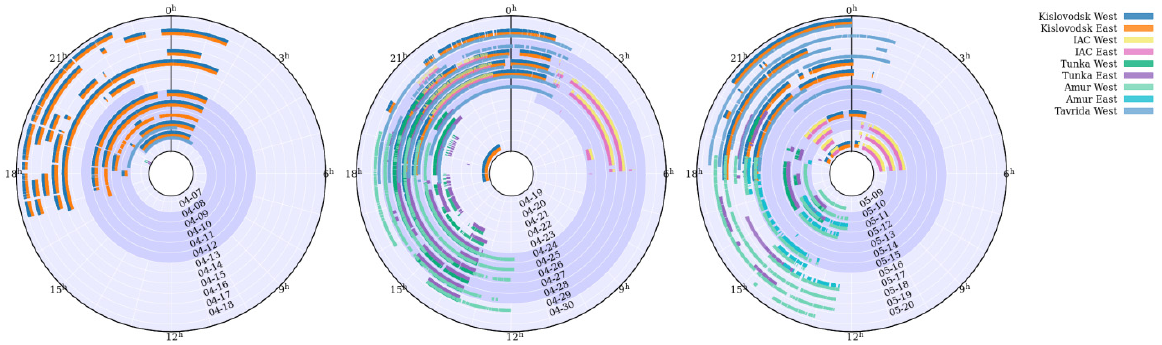
Figure 5. Schedule of synchronous observations of the FRB 180916.J0158+65 radio burst by five MASTER telescopes. The darker lilac rings show the moments of activity of the radio burster according to the ephemeris [53] © MASTER2022.